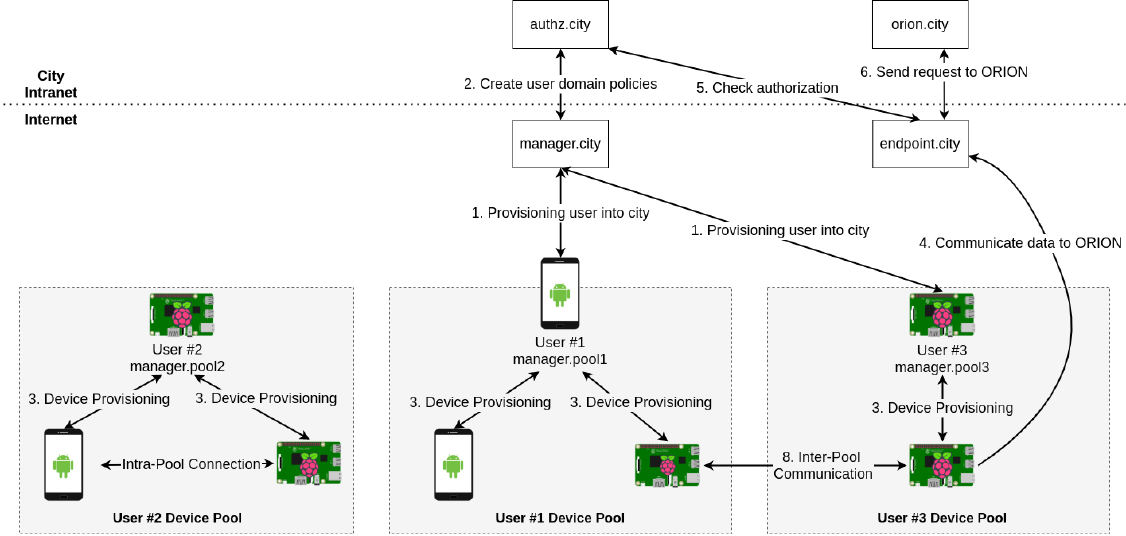
Figure 10. Setup integration with